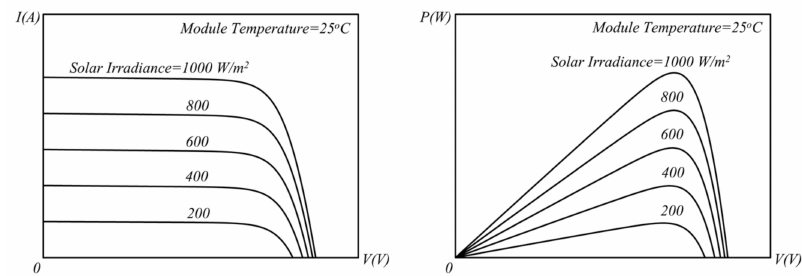
Figure 5. Effect of solar irradiance on the solar cells